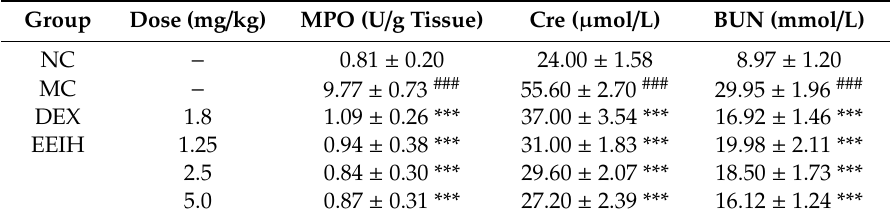
Figure 1. E ff ects of EEIH on histopathological changes of renal tissue in LPS-treated mice. The kidney sections were stained using hematoxylin and eosin. The light photomicrographs shown are representative of kidney sections from five mice per group. NC: normal control; MC: model control; DEX: dexamethasone (positive control). Table 3. E ff ects of EEIH on the renal myeloperoxidase (MPO) activity and serum creatinine (Cre) and blood urea nitrogen (BUN) levels in LPS-treated